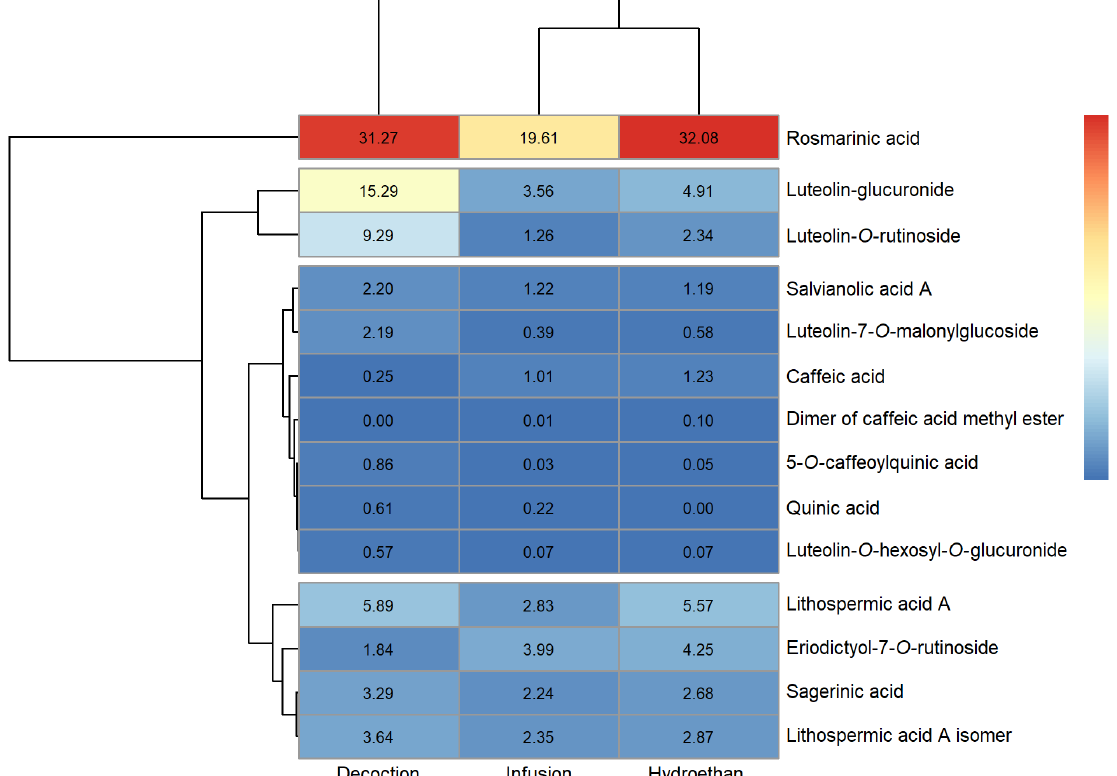
Figure 3. Clustered heatmap visualisation of phenolic compounds detected in spearmint infusion, decoction and hydroethanolic extract (units: mg/g).